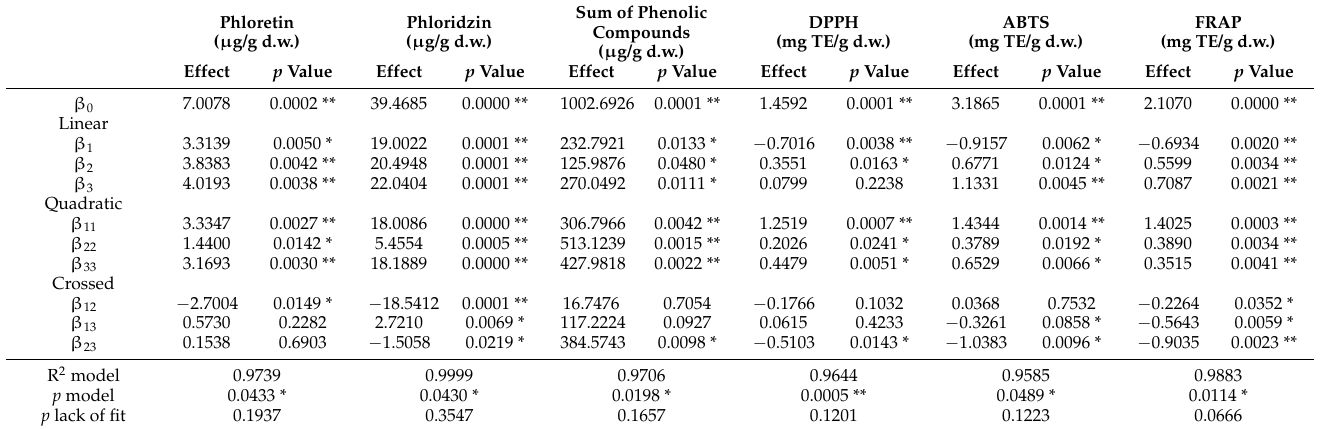
Table 3. Estimated regression coefficients of the adjusted second-order polynomial equation and analysis of variance (ANOVA) of the